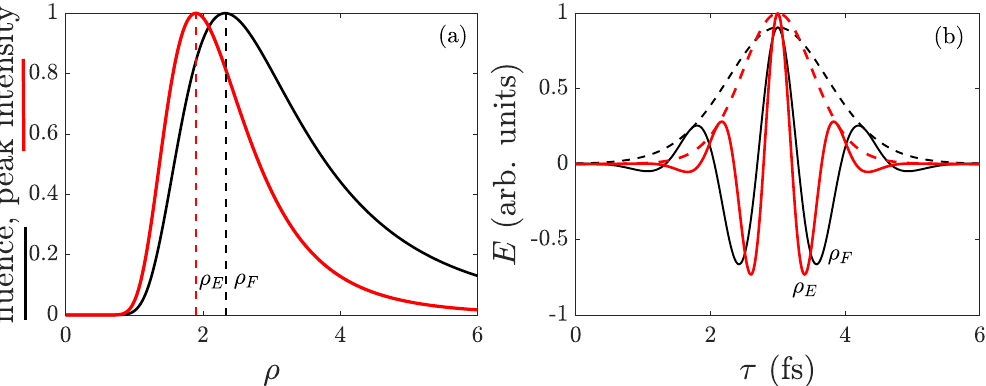
Figure 1. ( a ) Radial profile of fluence, F , and peak intensity, | E ( ρ ,0 ) | 2 , of the ultrafast vortex with topological charge l = 27 and spectrum ˆ a ω = ω 0.5 e − ω /2.5 of mean frequency ¯ ω = 2.5 fs − 1 , normalized to their respective maxima on the respective caustic surfaces ρ F = 2.32 fs 1/2 and ρ E = 1.90 fs 1/2 . ( b ) Respective pulse shapes (real field and amplitudes) on these two caustic surfaces, oscillating at different carrier frequencies, ¯ ω ( ρ F ) = 2.5 fs − 1 (cid:39) ¯ ω and ¯ ω ( ρ E ) = 3.616 fs − 1 , and with different durations. For a better comparison, the four curves are normalized to the peak amplitude of the pulse at ρ E